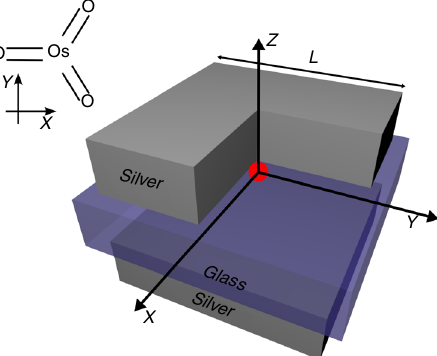
Fig. 1 Geometries of nanoantenna and example molecule . The nanoantenna is made of two cuboid silver patches of size L ´ L ´ 50 nm, separated with a 30-nm thick dielectric spacer with a side length L þ 20 nm. Please note the upper cuboidal patch is identical to the lower one, while the cut in the fi gure serves only visualization purposes, so that the location of the molecule can be seen. Geometry of the OsO molecule is sketched in the corner. The 3 molecule is positioned in the center of the nanoantenna indicated by the red dot, with all atoms in the xy